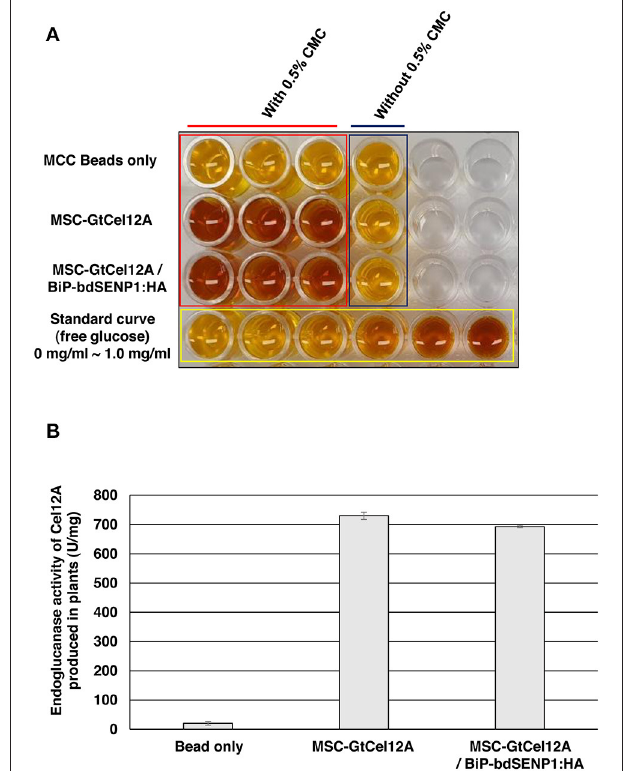
FIGURE 4 | GtCel12A-CBM3 immobilized on MCC beads harbors endoglucanase activity. (A) The endoglucanase activity of GtCel12A-CBM3 immobilized on MCC beads was determined by reducing sugar content measurement using dinitrosalicylic acid (DNS) assay. The endoglucanase activity is shown by the change in DNS color. (B) Quantification of specific GtCel12A-CBM3 activity. One unit (U) is defined as the amount of GtCel12A-CBM3 that can release 1 µ mol of glucose from CMC per min. All the reactions were performed three times (biological replicates) and each reaction was performed in triplicate per plate (technical replicates). Data represent means ( n = 3) ± standard deviation in which n represents biological replicates.